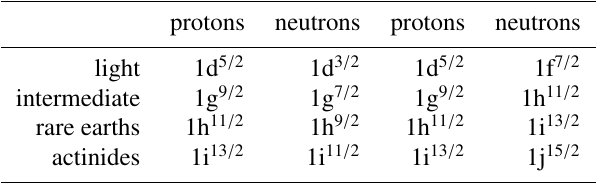
Table 1. Pairs of orbitals playing a leading role in the development of deformation in di ff erent mass regions of the nuclear chart according to Federman and Pittel [63–65]. The pairs on the left part of the table contribute in the beginning of the relevant shell, while the pairs on the right become important further within the shell. Adapted from Ref.